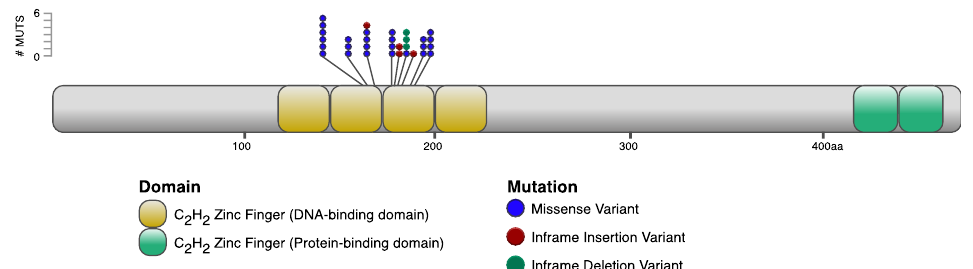
Figure 2. A schematic presentation of the Ikaros protein showing the collection of somatic nonsyn- onymous mutations in MD tumors that cluster on essential amino acids in N-terminal zinc fingers 2 and 3 (DNA-binding). Table 2. Tumor incidence in control birds or those infected with various recombinant MDVs.